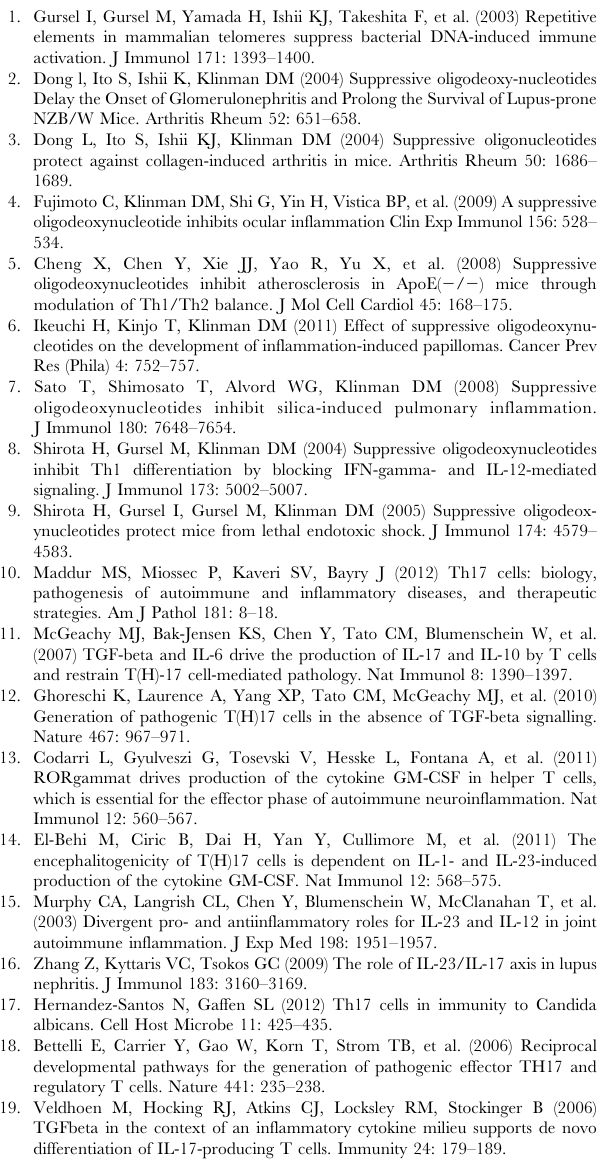
Figure S2 Effect of suppressive ODN on STAT1 and STAT5